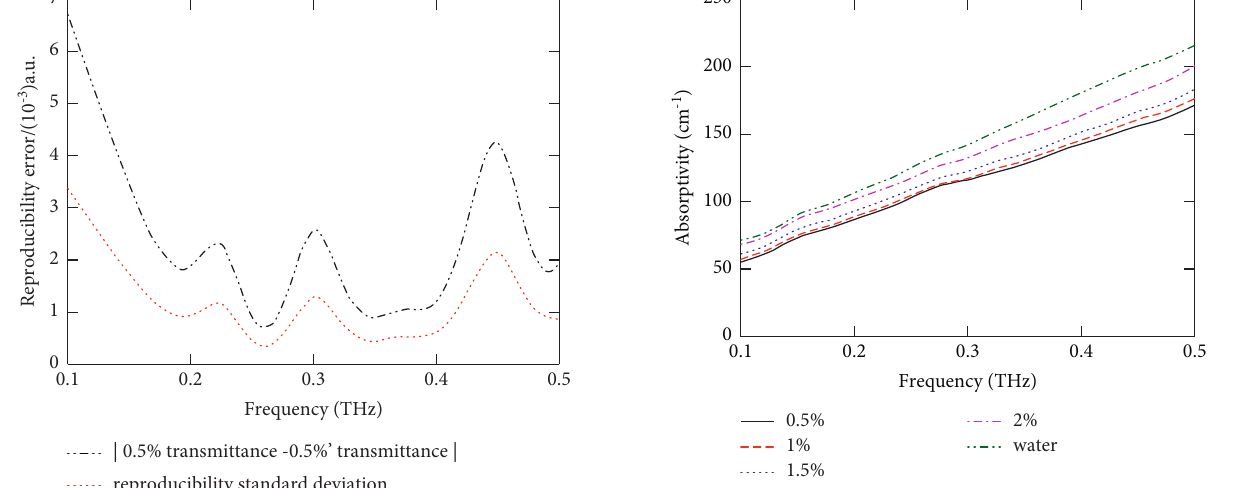
Figure 6: Error analysis of repeated injection of the same sample.